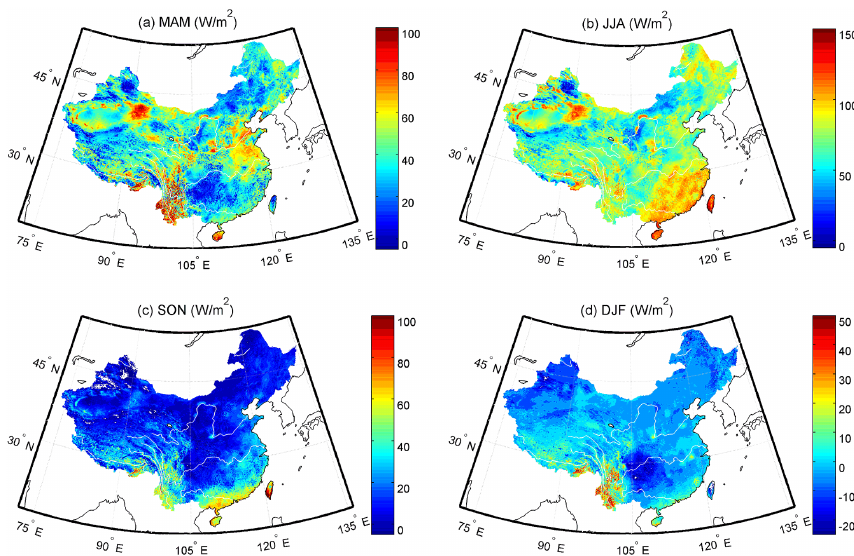
Figure 10. Maps of seasonal average latent heat flux for (a) March–May (MAM), (b) June–August (JJA), (c) September–November (SON), and (d) December–February (DJF) from 2001 to 2010. White lines show several major rivers in China.